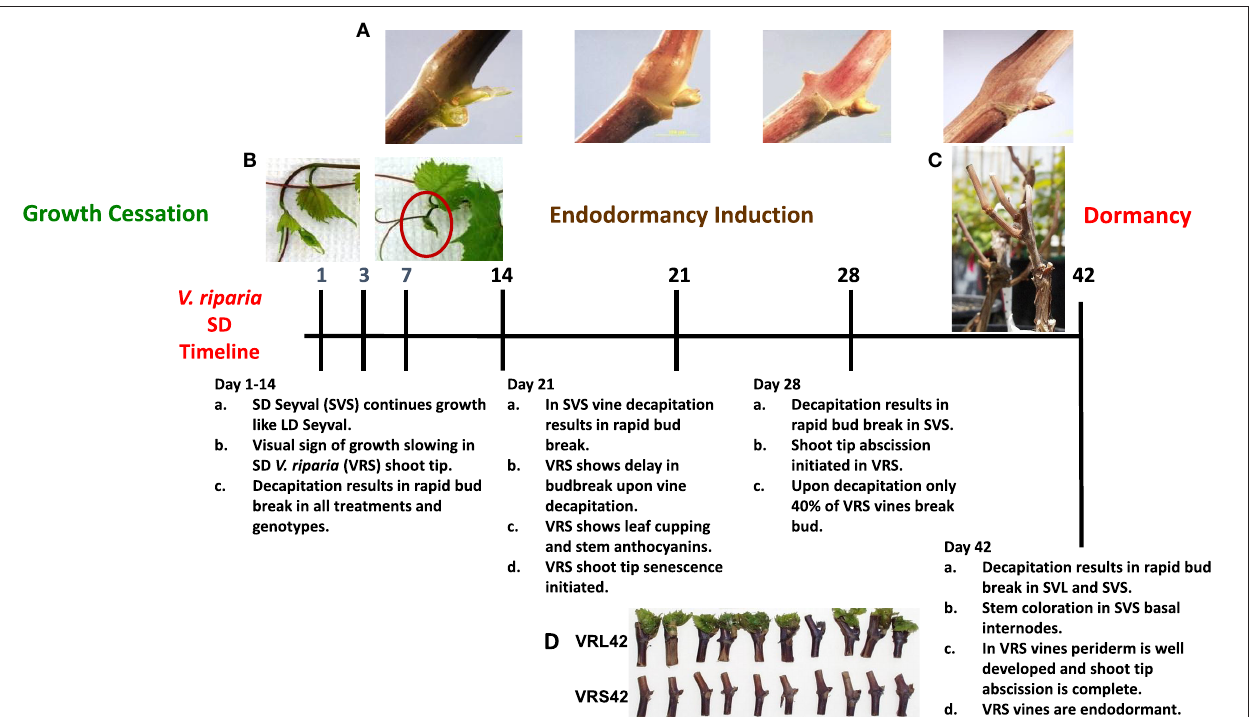
FIGURE 1 | Short photoperiod dormancy development timeline in V. riparia with reference to Seyval’s lack of dormancy development under short photoperiods. (A) Overwintering latent buds from short day (SD) treatment show budscale development and periderm development; (B) Actively growing V. riparia shoot tip from long day (LD) vines and V. riparia SD shoot tip during growth cessation (SD14); (C) Decapitated and dormant SD V. riparia (VRS) grapevine, the photograph was taken 28 days after the decapitated SD42 vine was returned to LD-forcing conditions; (D) Individual nodes (3–12 from shoot base, left to right) from V. riparia LD or SD vines (VRL42 or VRS42), the photo was taken 28 days after placing node sections in LD forcing